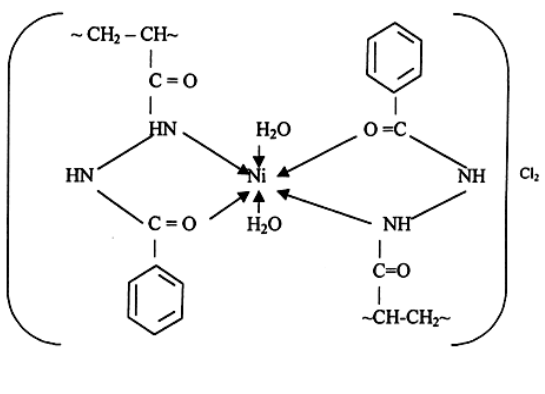
Figure 1. A complex of poly(acryloyl benzoic hydrazide) with nickel ion